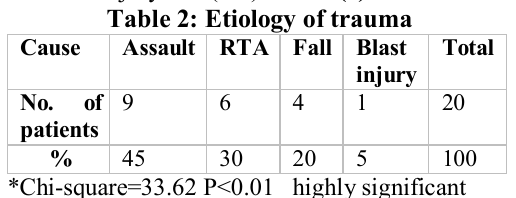
Table 2: Etiology of